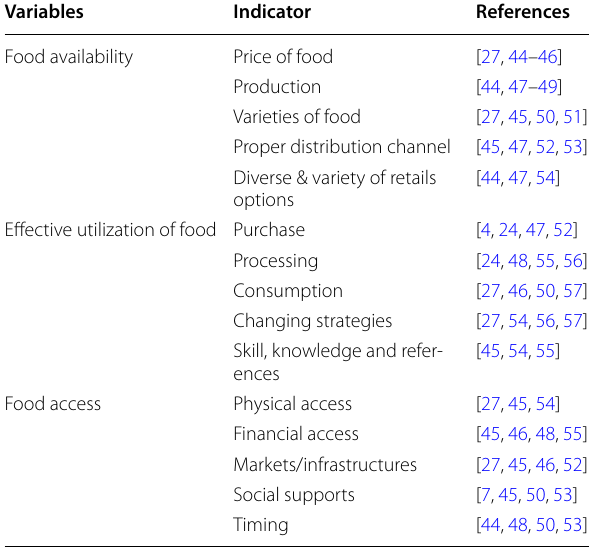
Table 1 Selected indicator of FS of the study Variables